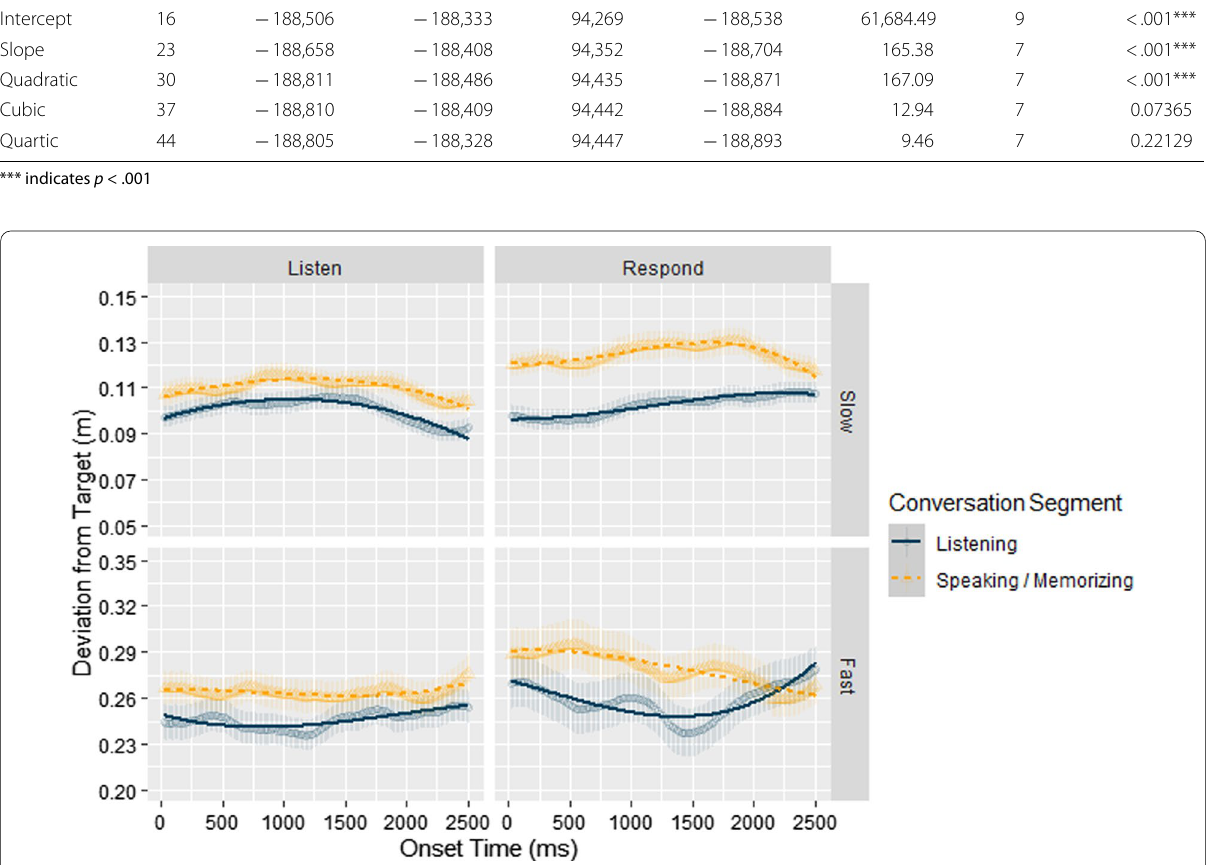
Fig. 3 Deviation from target during first 2500 ms of segment onset for Slow and Fast speeds during Listen and Respond conversation conditions in E1. Error bars show the SEM. Note that for reasons of graphical clarity, the scales used for the fast and slow target movement conditions are different